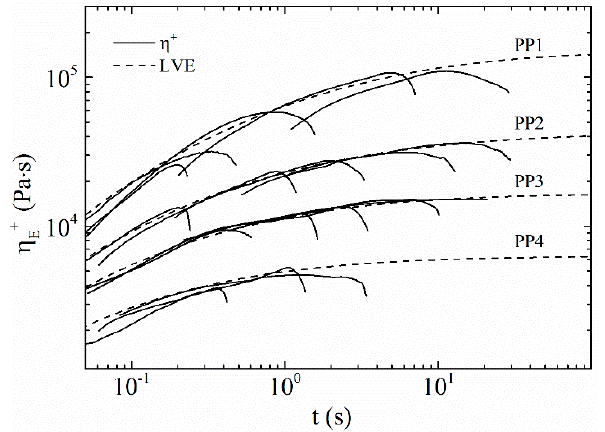
Figure 11. Extensional rheology of the linear PPs.